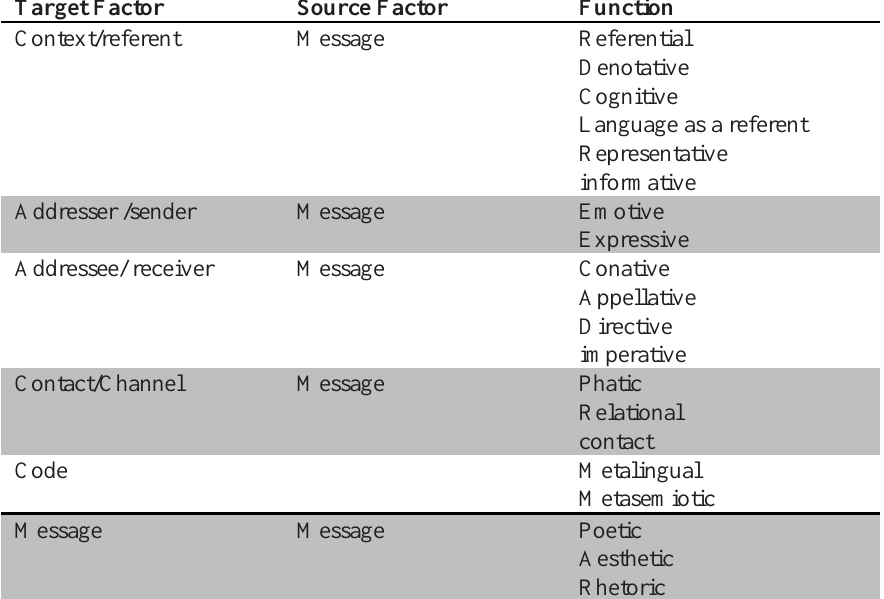
Table 1. Six Elements/Factors of Verbal Communication by Jakobson (1960) Target